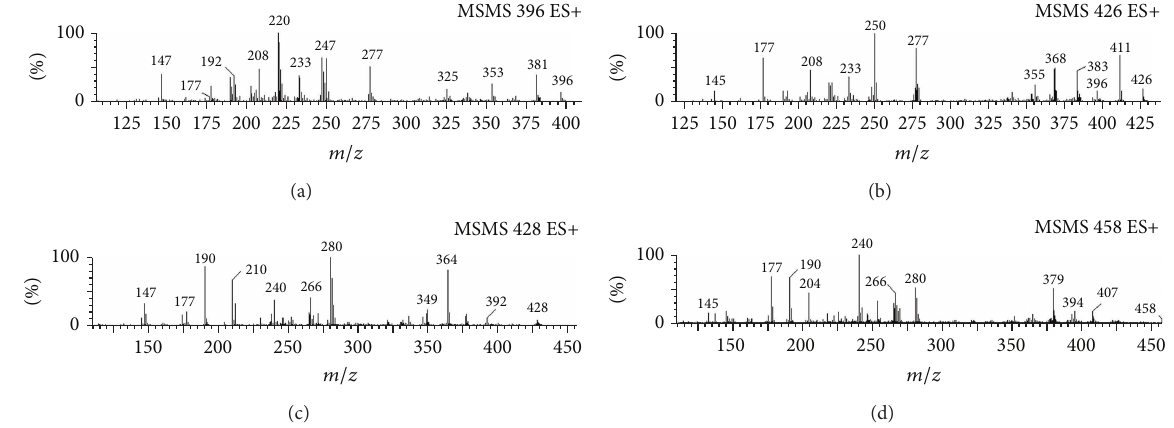
Figure 7: CID-MS/MS spectra of ions [dCurc-H + Co] + ((a) CE = 20V) and [dCurc-H + FeCl] + ((c) CE = 15V) and for comparison the MS/MS spectra of ions [Curc-H + Co] + ((b) CE = 20V) and [Curc-H + FeCl] + ((d) CE = 20